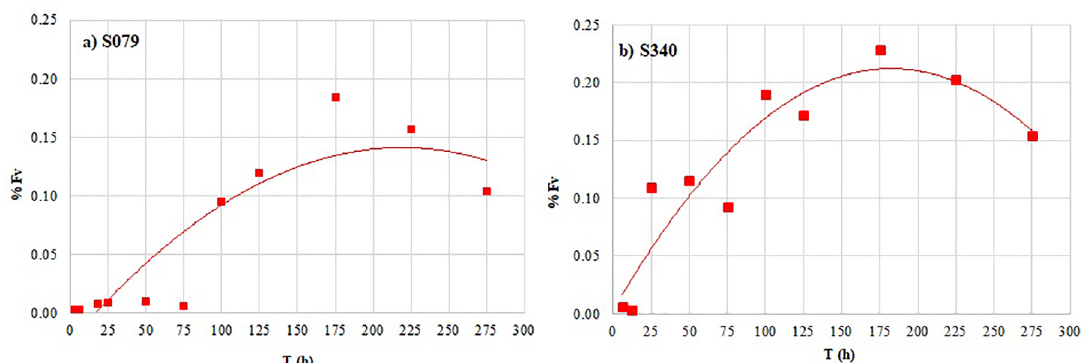
Figure 2. Measurement of volumetric fraction from alloys S79 (a) and S340 (b) against aging time.